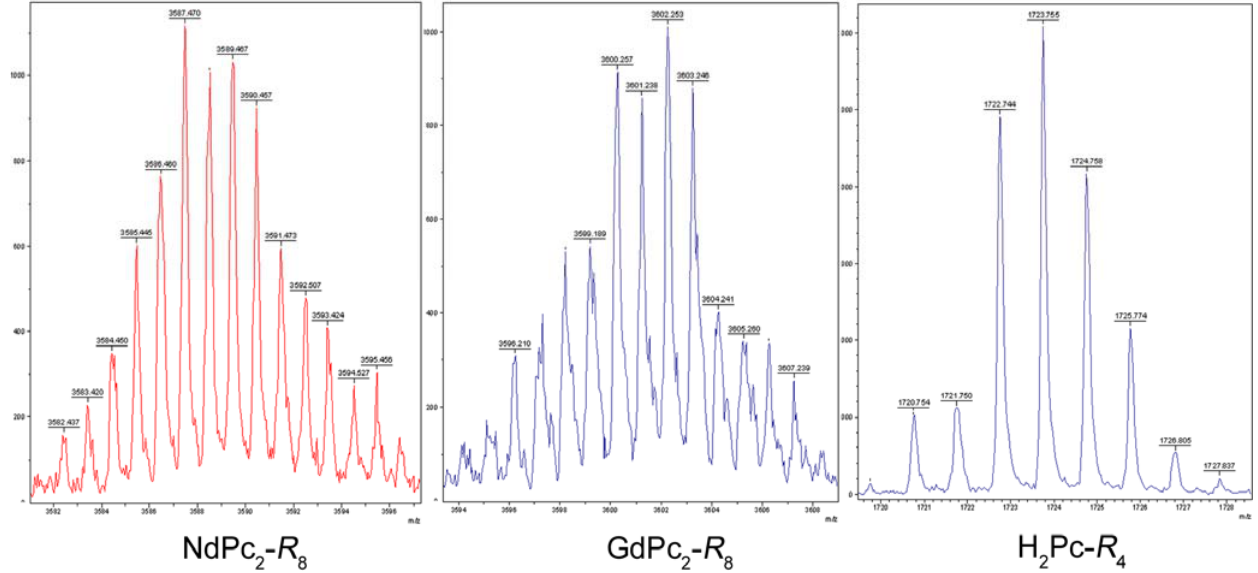
Figure 5. Mass spectra (MALDI-ToF) of the novel bis-phthalocyanines and the metal-free base phthalocyanine; spectra patterns of NdPc shown to confirm the molecular structure of the synthesized complexes (see Table 1).